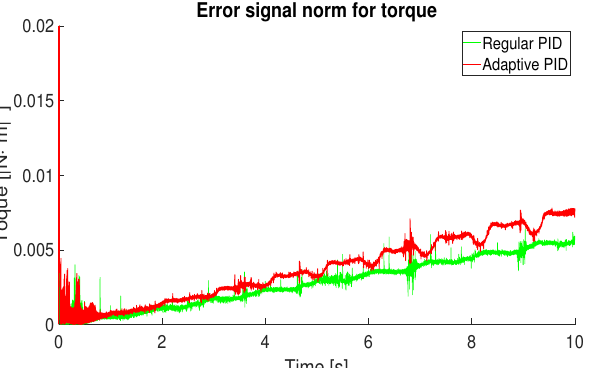
Figure 10. Norm of the tracking errors with the application of the regular PID and the adaptive